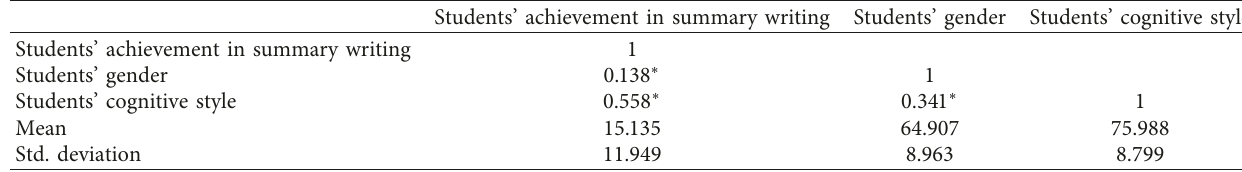
Table 1: Correlation matrix of cognitive style and gender on students’ achievement in summary writing. Students’ achievement in summary writing Students’ gender Students’ cognitive style